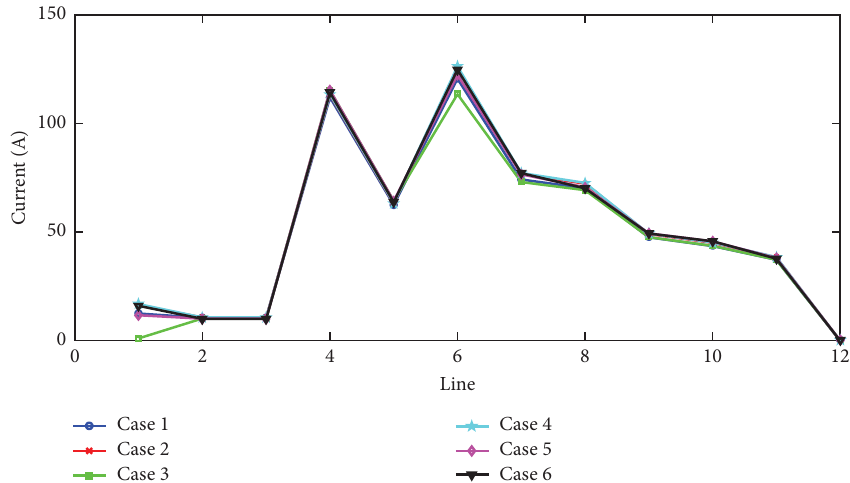
Figure 3: Neutral wire current of the lines in diferent case